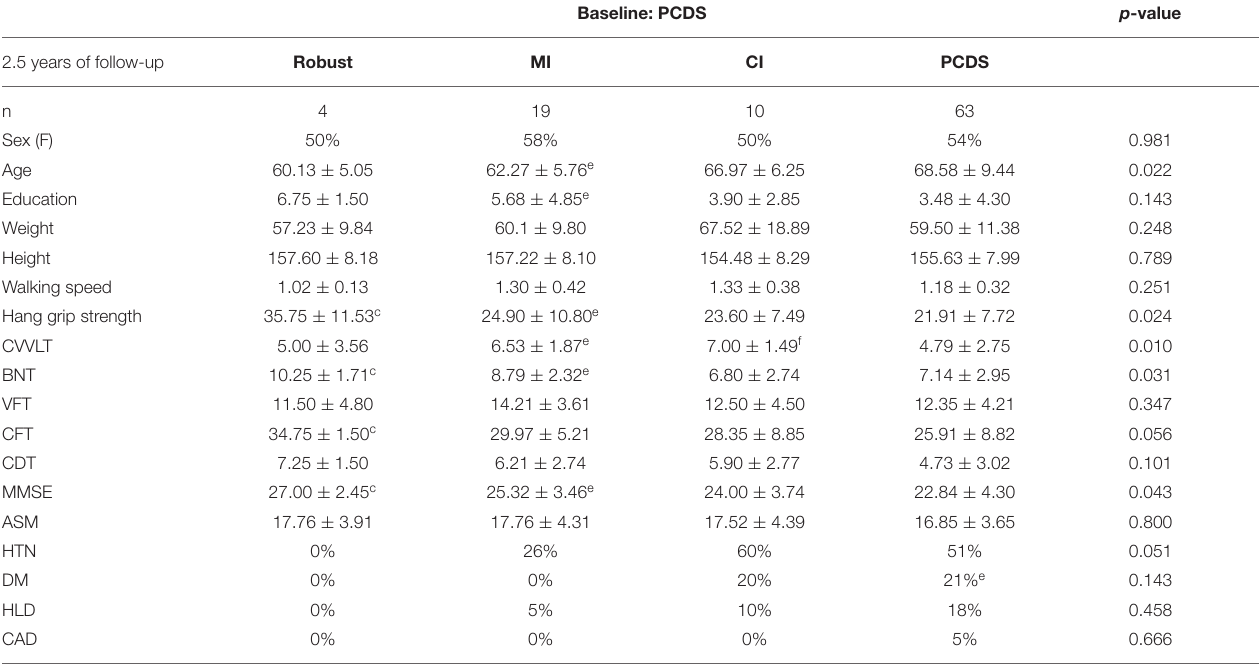
TABLE 2 | Comparisons of the baseline physical and cognitive performance of four groups transited from participants with PCDS ( n = 96). Baseline: PCDS p